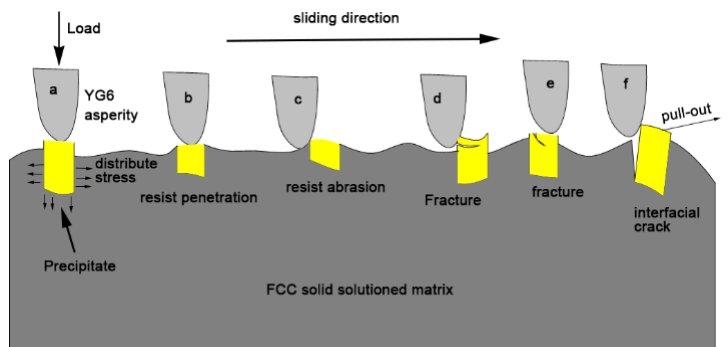
Figure 14. The schematic diagram of the behavior of precipitates in the wear